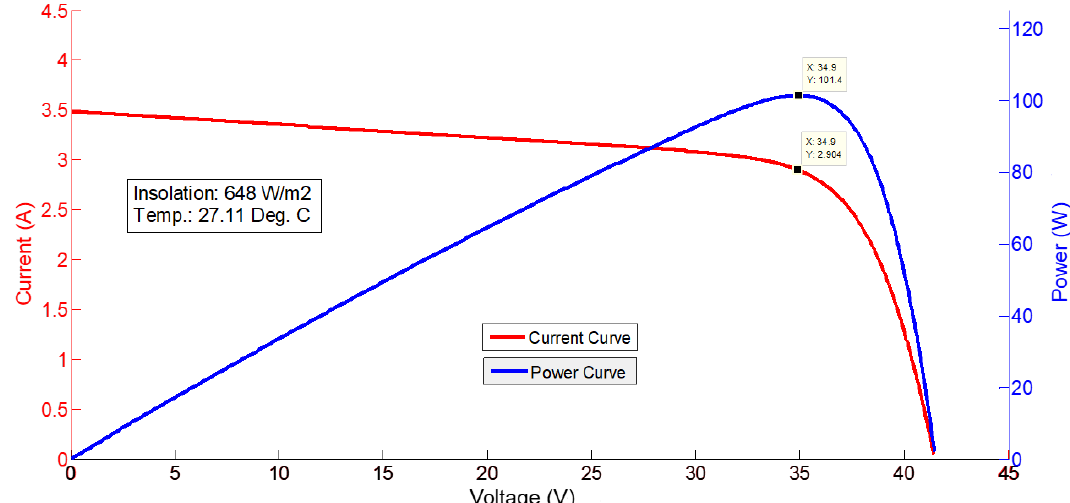
Figure 14. I-V and P-V characteristic of PV array at 13:00.